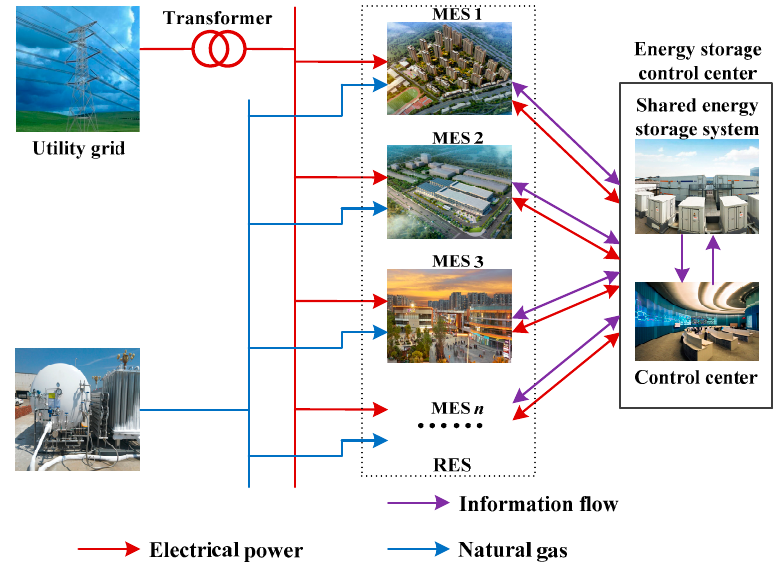
Figure 2. Multi-RES with SESS.